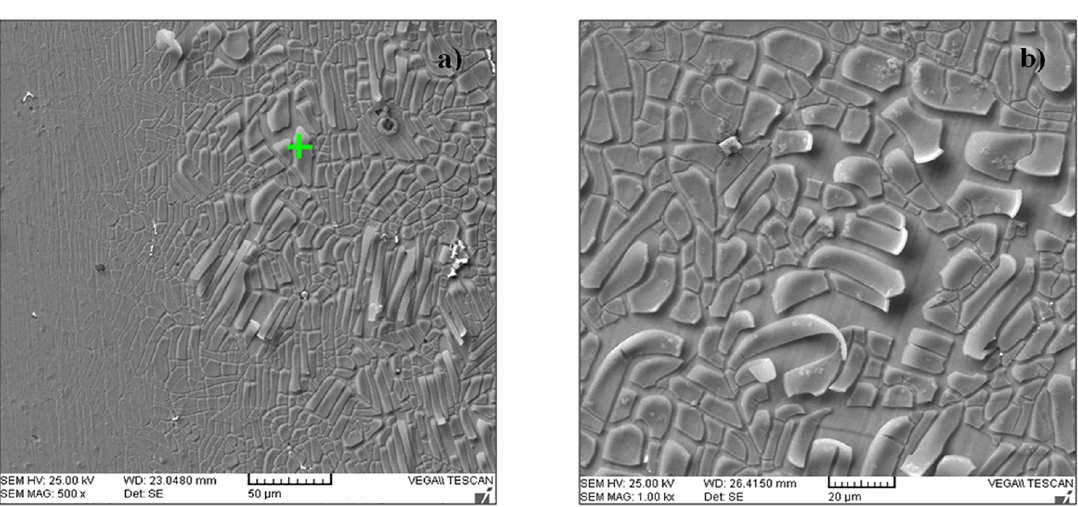
Figure 13. SEM of the 22% manganese steel corrosion products in aqueous solution 0.1M NaCl. Source: author